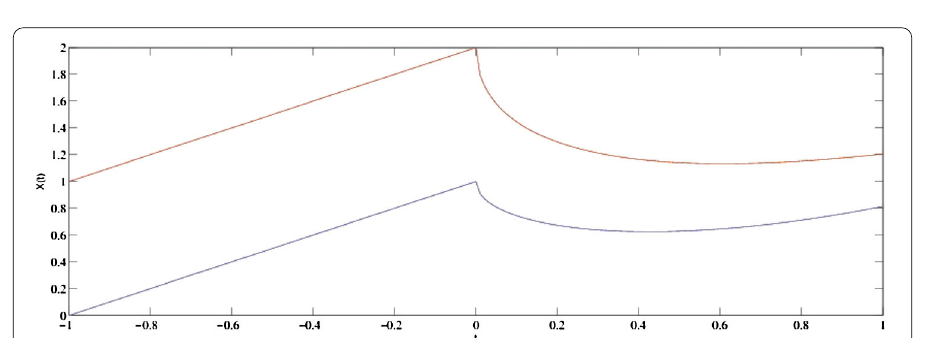
Figure 2 The w -decreasing solution of Example 3.5 in Case